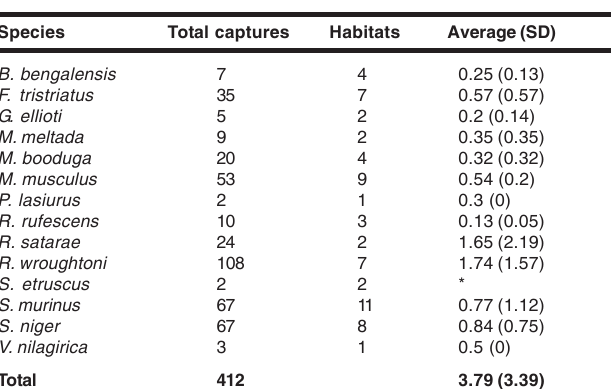
Funambulus tristriatus Platacanthomys lasiurus Suncus etruscus